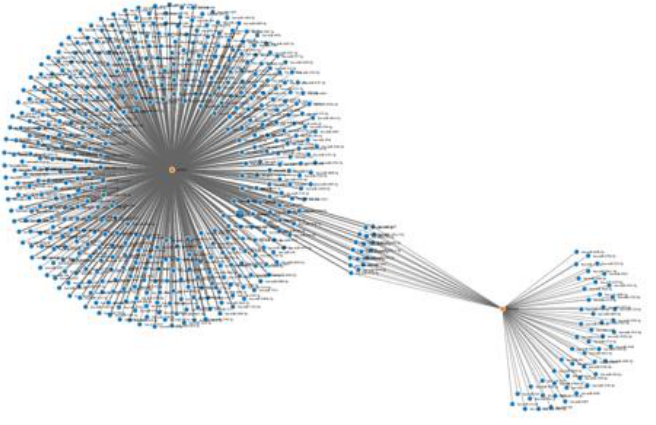
Figure 2. Plausible interactive networks of microRNA regulation on SCN5A and SCN10A as pre- dicted using MirWalk